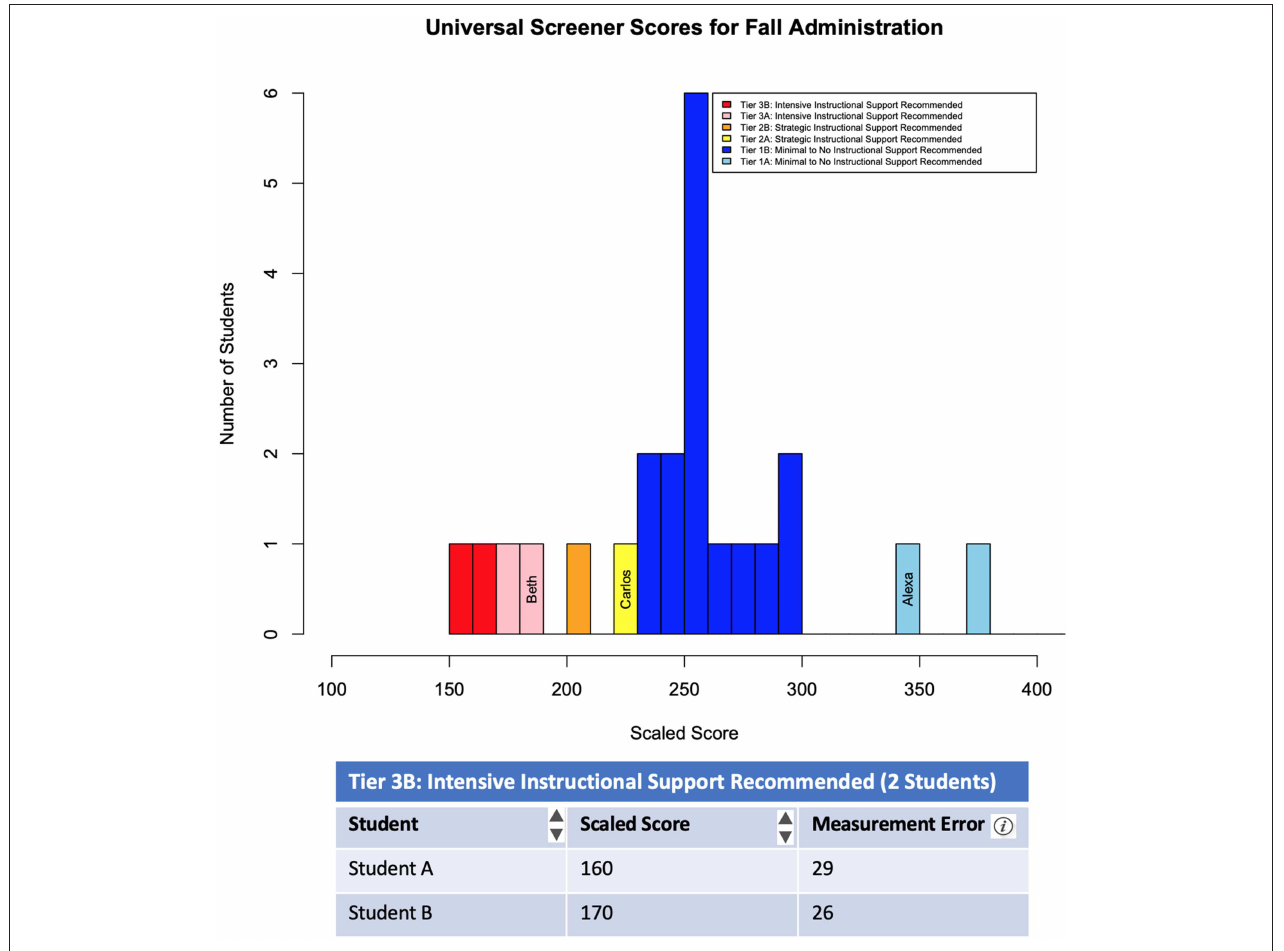
FIGURE 1 | The Class Summary Report (students’ names hidden; rest of table not shown). Each tier is divided into two additional tiers (A or B), with B having a lower scaled score than